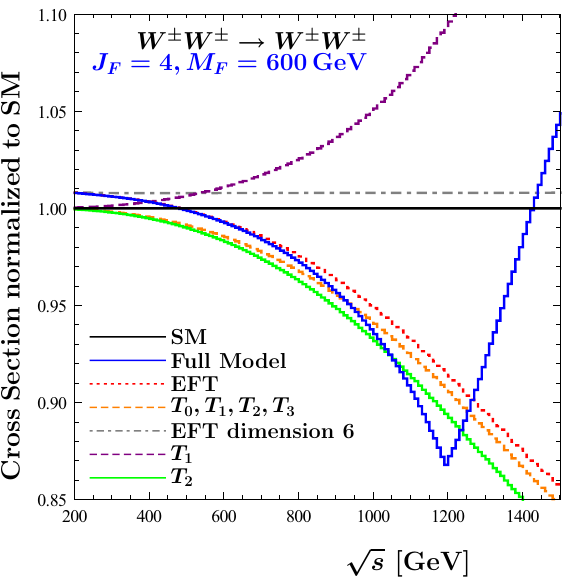
Fig. 7 Ratioof the unpolarized cross sections for same-sign WW scat- tering(leftpanel)andthe WW → Z Z process(rightpanel)inthesingle fermion multiplet model with ( J F = 4 , M F = 600GeV ) to the corre-